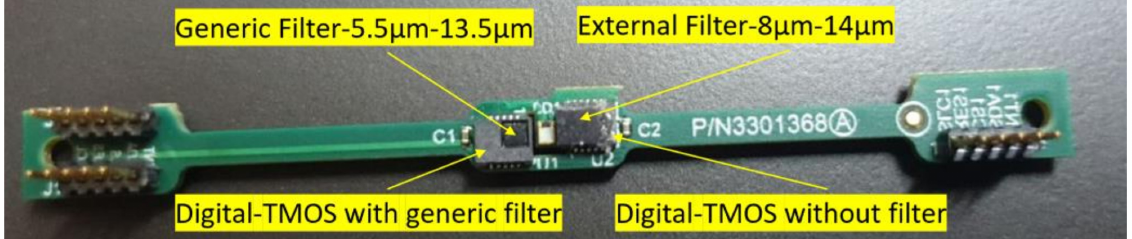
Figure 4. Image of the device under study with two channels.